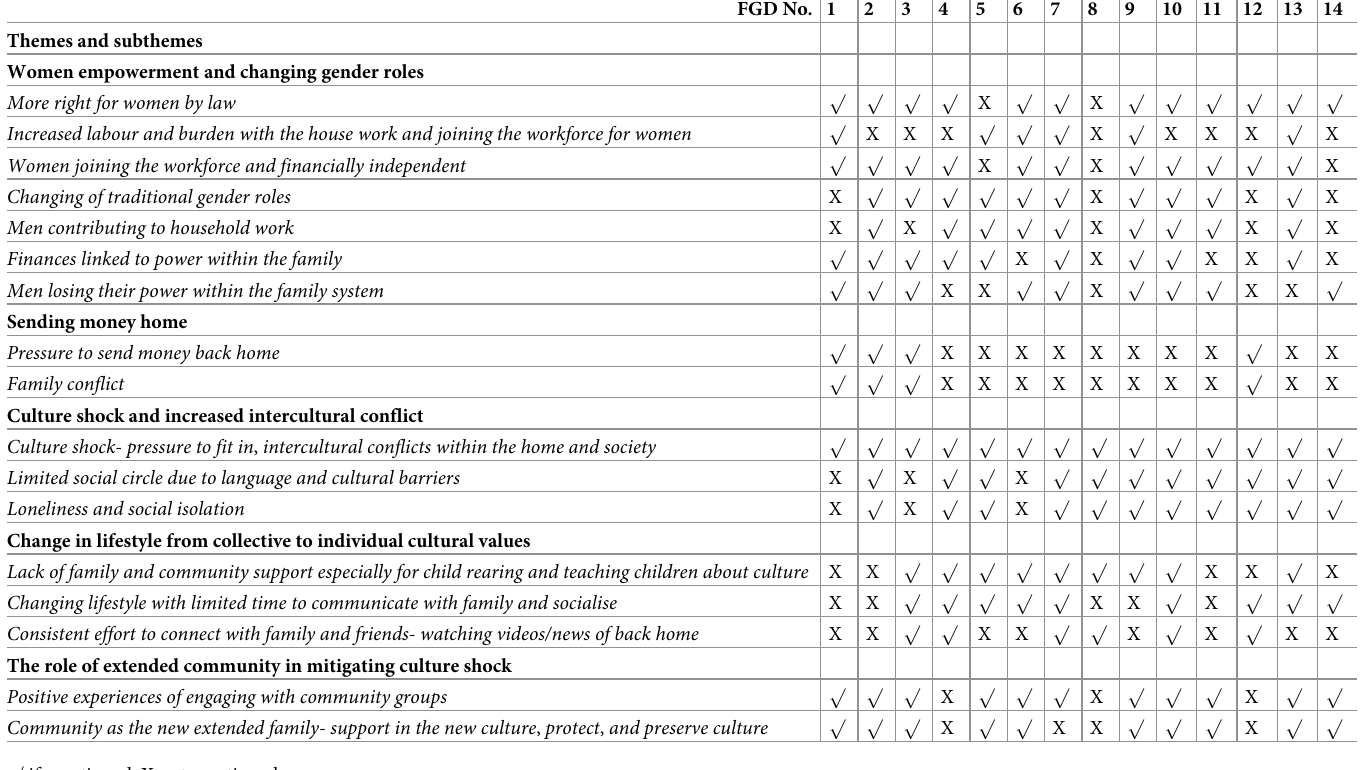
Table 2. Major themes and subthemes from the